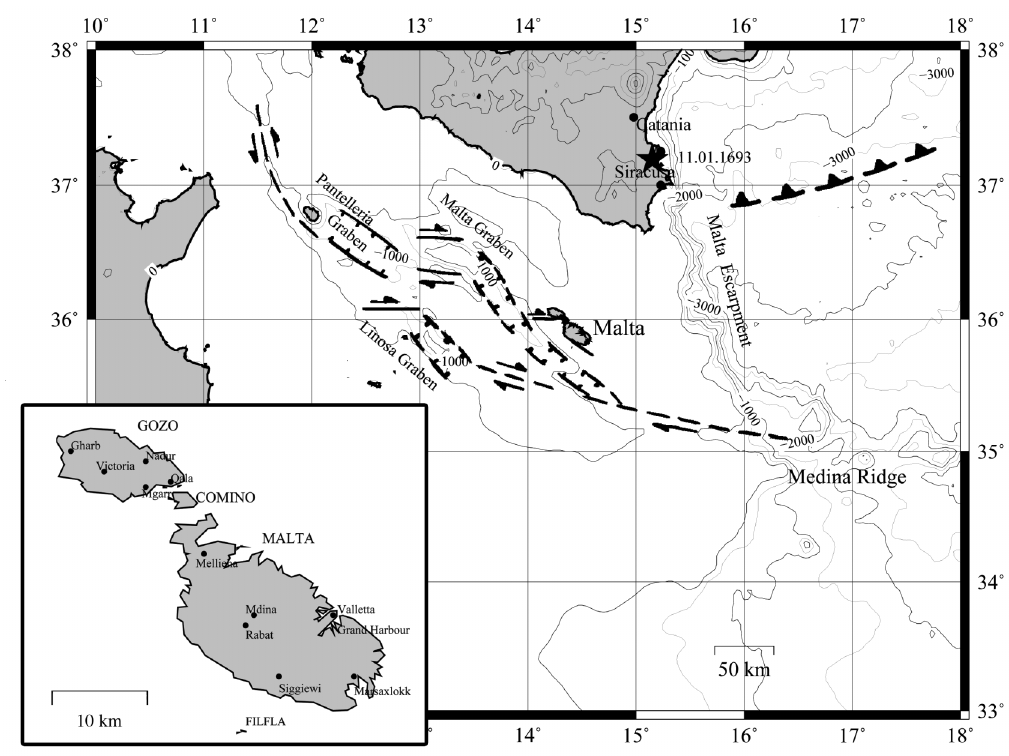
Fig. 1. Bathymetry of the Sicily Channel and main tectonic features of the Sicily Channel Rift Zone-bounding normal faults and strike-slip lineaments (modified after Reuther and Eisbacher, 1985 and Reuther, 1990). Also shown are the Calabrian Arc subduction zone and epicentre of the 11/01/1693 earthquake (Boschi et al., 2000). Inset shows the Maltese